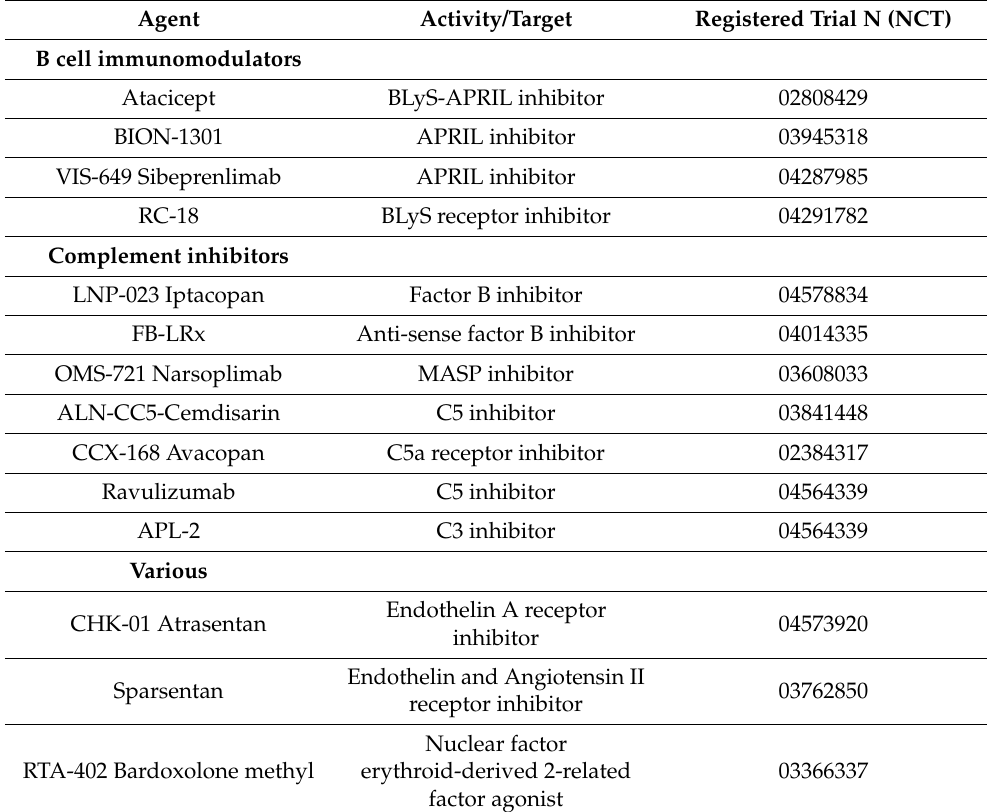
Table 1. New drugs under evaluation for treatment of IgA nephropathy: selected from studies published in the U.S. National Library of Medicine Clinical